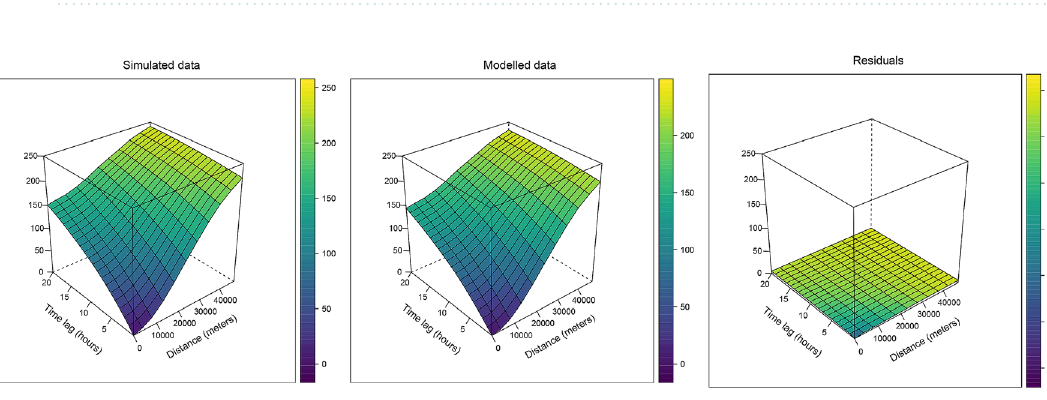
Table 1. Comparison of the test MAE resulting from a model following our novel framework—in which all the spatial coefficients are learned at once with a multiple output deep neural network—and the one obtained through an approach in which each coefficient map is predicted using a separate single output regression model.